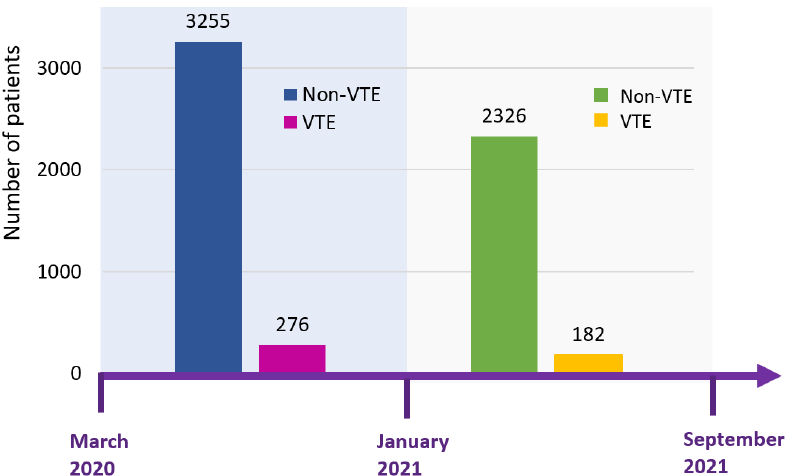
Figure 1. Timeline of two study cohorts of COVID-19. Patients from March to December 2020 were used for the training cohort, whereas patients from January to September 2021 were used for the validation cohort. The incidence of VTE was 7.8% in the derivation cohort and 7.3% in the validation cohort. Abbreviation: VTE, venous thromboembolism.